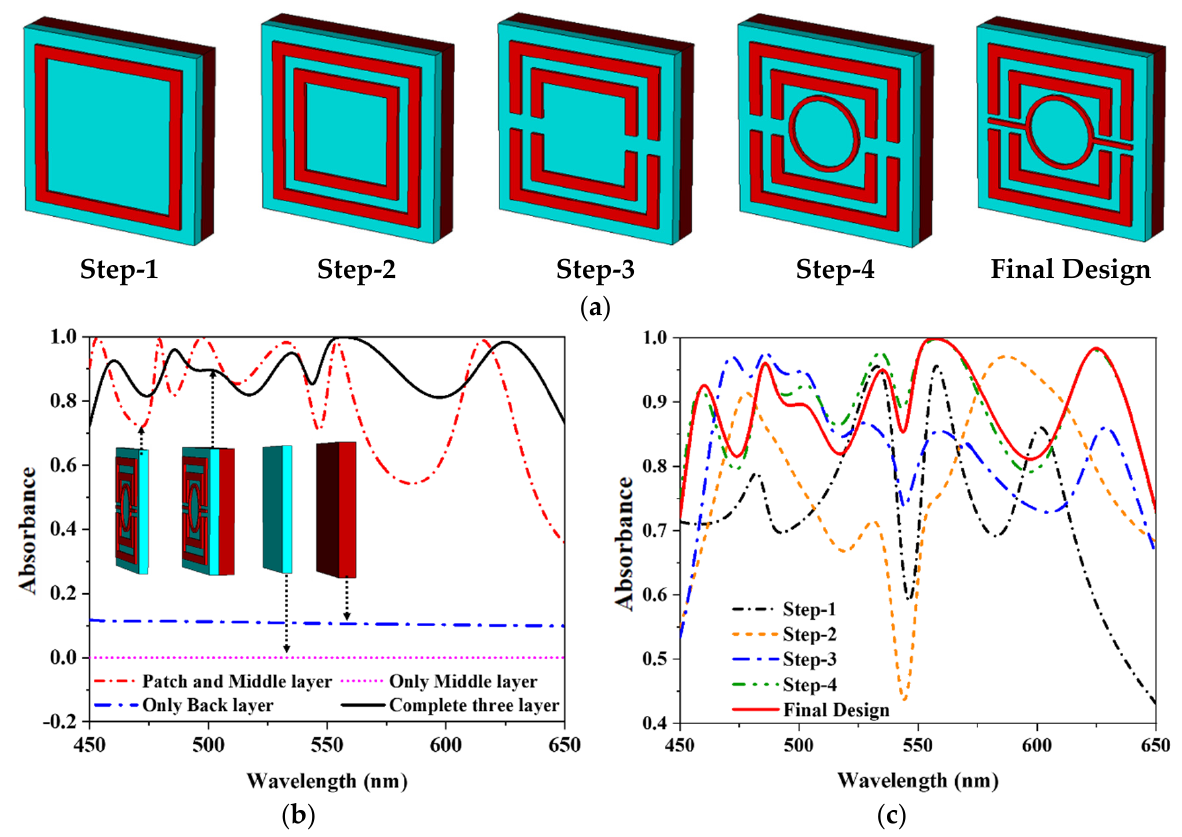
Figure 4. The absorbance of unit cell (a) design step( b ) different layers and ( c ) design